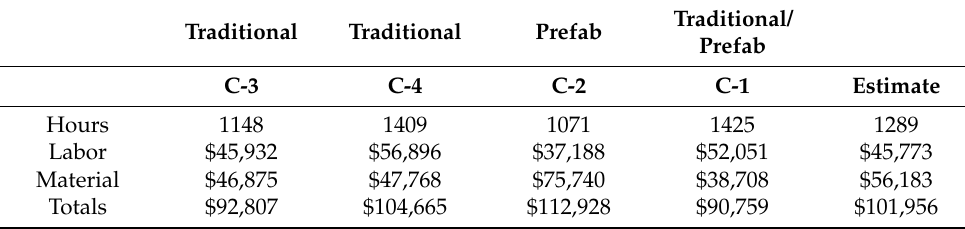
Table 2. Resulting labor and material data along with estimated values from project